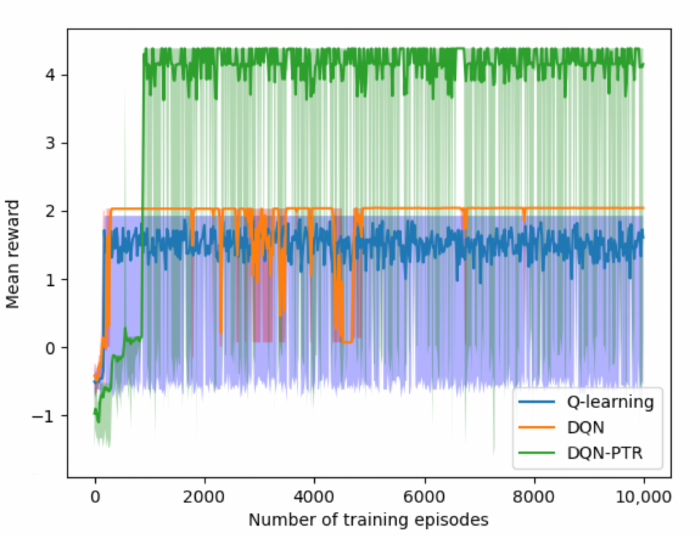
Figure 6. Learning curves of Q-learning (blue), CQN (orange) and DQN-PTR